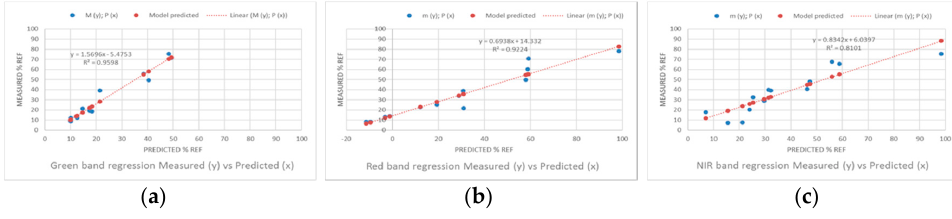
Figure 14. OLS regression of M against P reflectance per sample for G ( a ); Red ( b ) and NIR ( c ) from EL2 Spect .